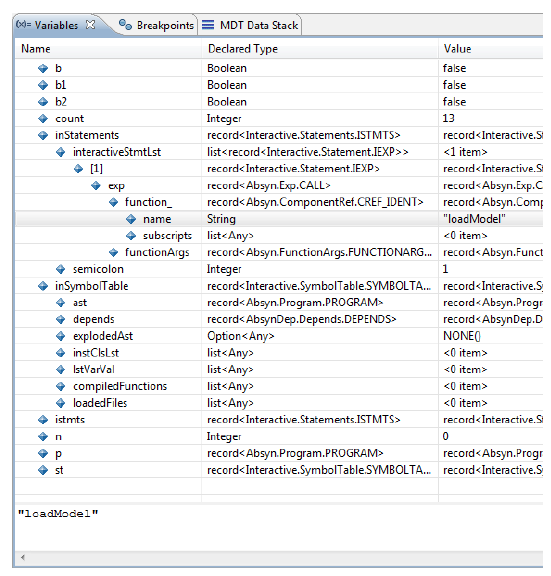
Figure 5: The variable view of the new